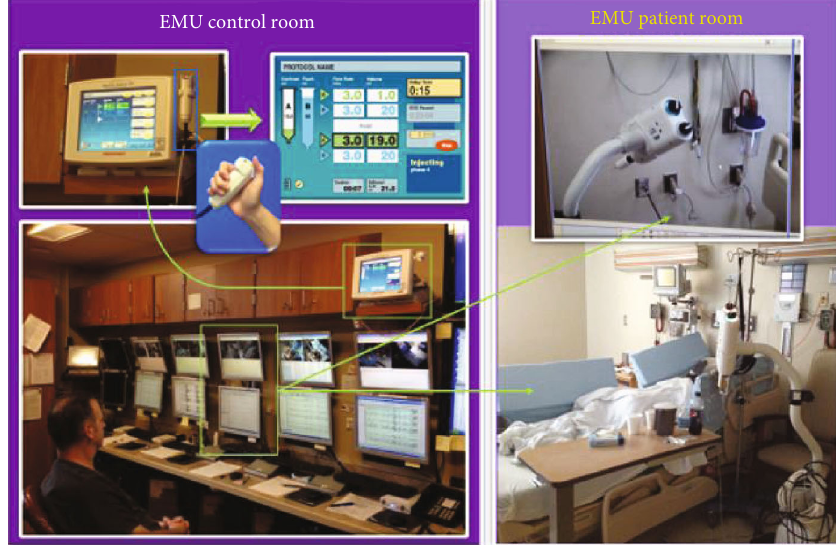
Figure 3: Demonstration of the use of automatic SPECT injectors at the Epilepsy Monitoring Unit (EMU) of the University of Pittsburgh Medical Center (UPMC) at Presbyterian University Hospital (PUH). Automatic injectors are armed by nuclear medicine sta ff . The radiotracer is injected upon a button press by the EMU sta ff in the EMU control room (pictures on the left side) upon observing clinical or electrographic seizure a ff ecting the monitored patient (pictures on the right